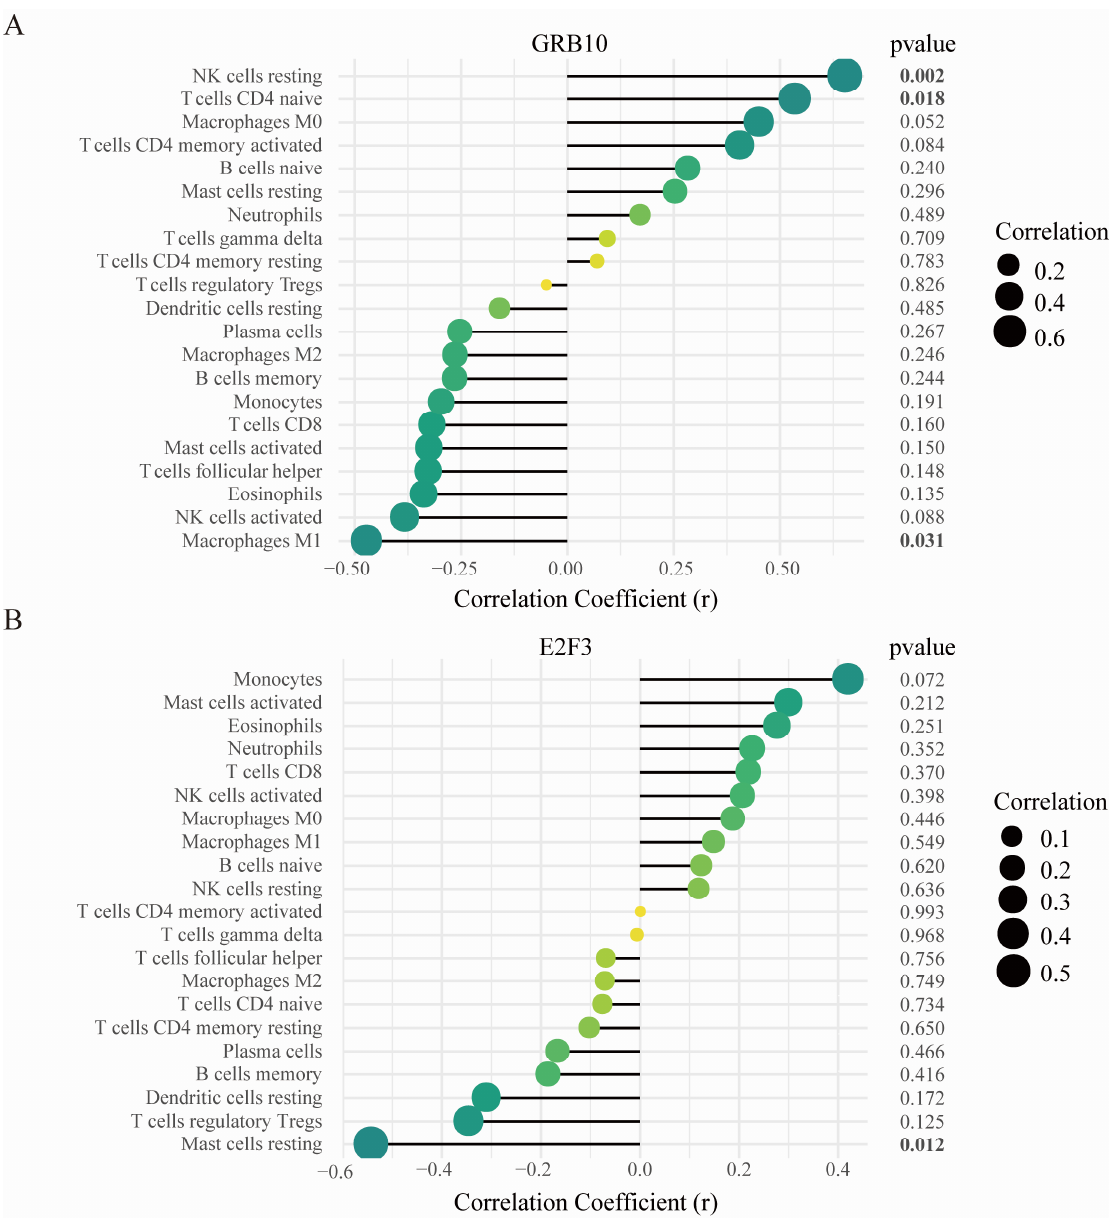
Figure 7. Correlation between GRB10, E2F3, and infiltrating immune cells. ( A ) Correlation between GRB10 and infiltrating immune cells. ( B ) Correlation between E2F3 and infiltrating immune cells. The size of the dots represents the strength of the correlation between genes and immune cells; the larger the dots, the stronger the correlation, and the smaller the dots, the weaker the correlation. The color of the dots represents the p-value, the greener the color, the lower the p-value, and the yellower the color, the larger the p-value. p < 0.05 was considered statistically significant.